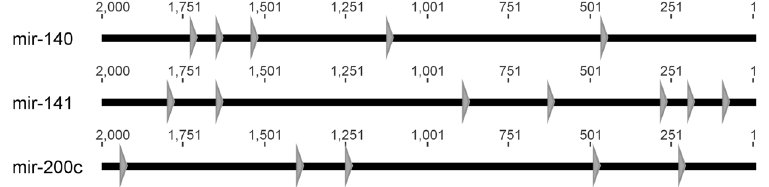
Figure 1. Signature microRNA genes contain SBE elements. Promoter analysis was conducted using the ChipMAPPER algorithm 21, 22 . microRNA genes -140, -141, and -200 contain putative SBE elements as represented by the triangle with conservative E-values less than or equal to 25 and a score greater than